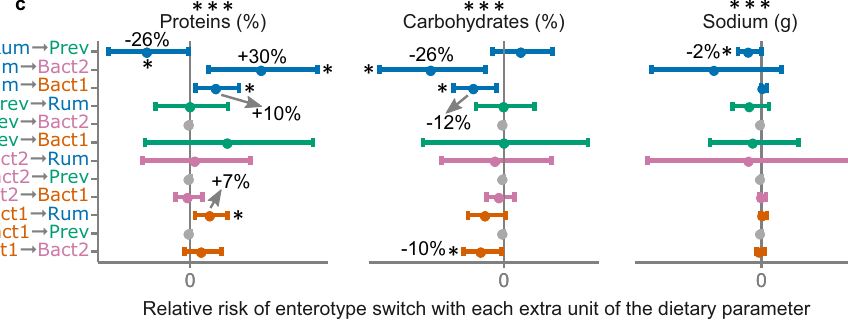
Fig. 7 The only host covariates of temporal microbiota variation reaching signi fi cance in current cohort are transit time, as assessed through stool moisture, and diet. a Independent effect sizes (adjusted R2) of non-redundant covariates on microbiome community variation corrected for individual effects (dbRDA on a BC dissimilarity matrix of QMPs, N = 19, n = 661). The only variable signi fi cantly contributing to microbiome community variation in a combined model corrected for individual effects was stool moisture (blue, stepwise dbRDA on a BC dissimilarity matrix of QMPs, N = 19, n =